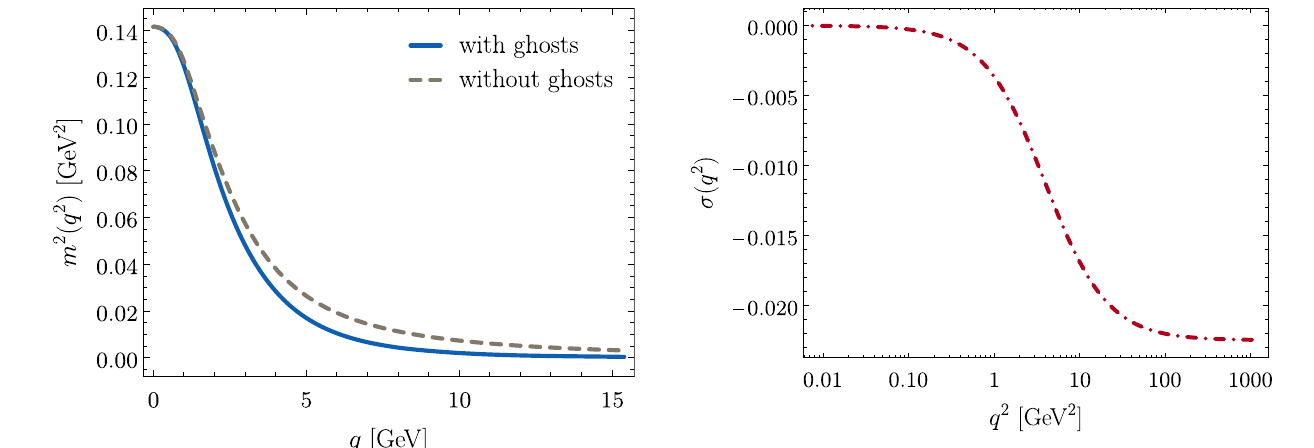
Fig. 10 The function σ( q 2 ) measuring the relative deviation of the gluon-ghost vertex form factors from their canonical form, due to the presence of the pole term parts, by using the results obtained so far in conjunction with Eqs. (2.23) and (4.15). The results are shown in Fig. 9;